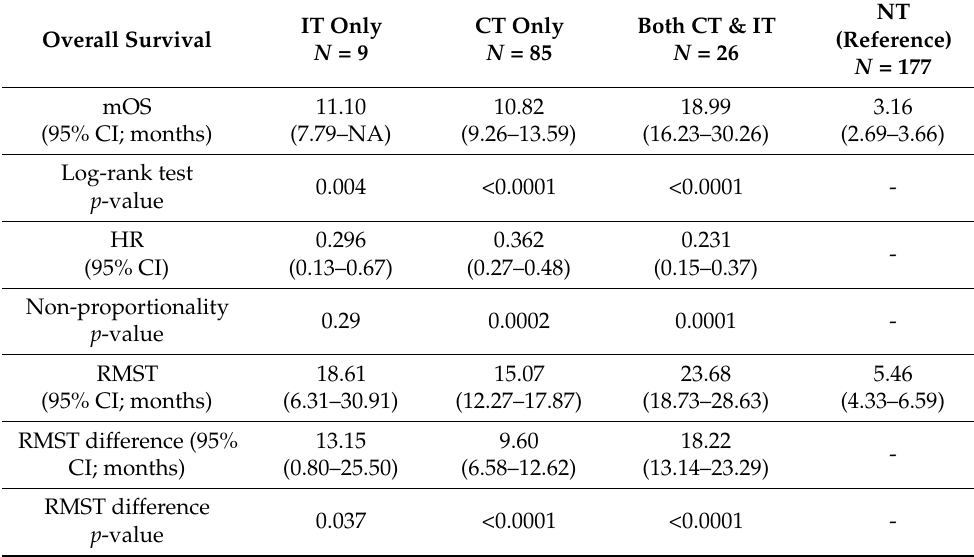
Table 2. Survival outcomes in patients receiving palliative therapies, calculated from date of metastasis.